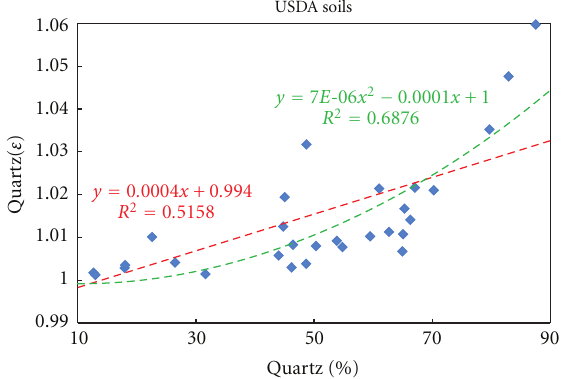
Figure 14: Comparison between the Quartz( ε ) and USDA deter- mined quartz% content with calculated linear (red) and power relation (green) models.